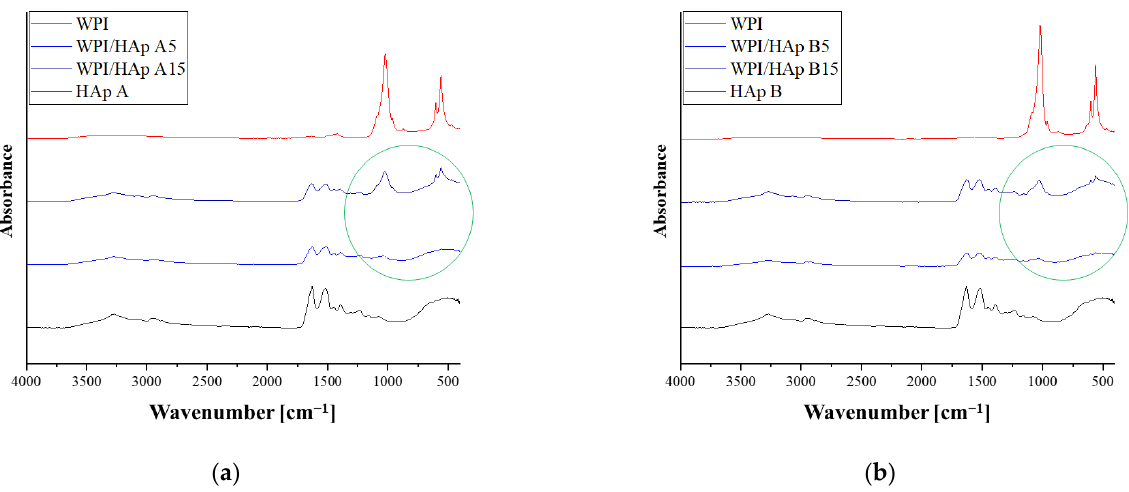
Figure 2. FT-IR spectra of composites with different Hap contents indicated by a green circle: ( a ) WPI/HAp A; ( b ) WPI/HAp B. Table 6. IR band assignment of WPI.